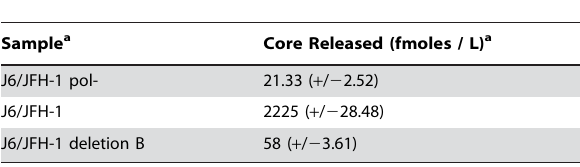
Table 1. Core protein